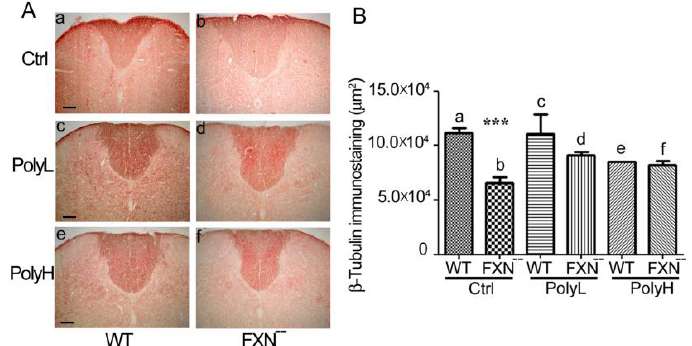
Figure 4. ( A ): β -tubulin expression in the dorsal funiculus of the spinal cord from WT and FXN – mutant mice in control conditions (Ctrl, a,b) as well as in the presence of low (Poly L, 0.0185 mg / gram of food, c,d) or high (Poly H, 0.185 mg / gram of food: e,f) EGCG dosages. The significant β -tubulin downregulation, observed as a consequence of the Frataxin gene mutation (a,b), was e ffi ciently counteracted upon EGCG administration under either the low (PolyL; 0.0185 mg / g) (c,d) or the high (PolyH; 0.185 mg / g) (e,f) concentration conditions. In these last case, very minor, non-significant di ff erences in terms of β -tubulin expression could be observed. ( B ): Morphometric analysis of β -tubulin expression in the spinal cord sections shown in ( A ), reported in control conditions (Ctrl, a,b) and in conditions of low (PolyL: c,d) or high (PolyH: e,f) dietary EGCG administration. ( A ) 45% downregulation was observed in the dorsal funiculus as a consequence of FXN – mutation (a,b) when a statistically significant p -value < 0.0001, indicated by ***, was demonstrated. On the other hand, no statistically-relevant di ff erences between the genotypes were observed in polyphenol-treated (either PolyL or PolyH) mice (c,d; e,f). Scale bar: 100 µm.